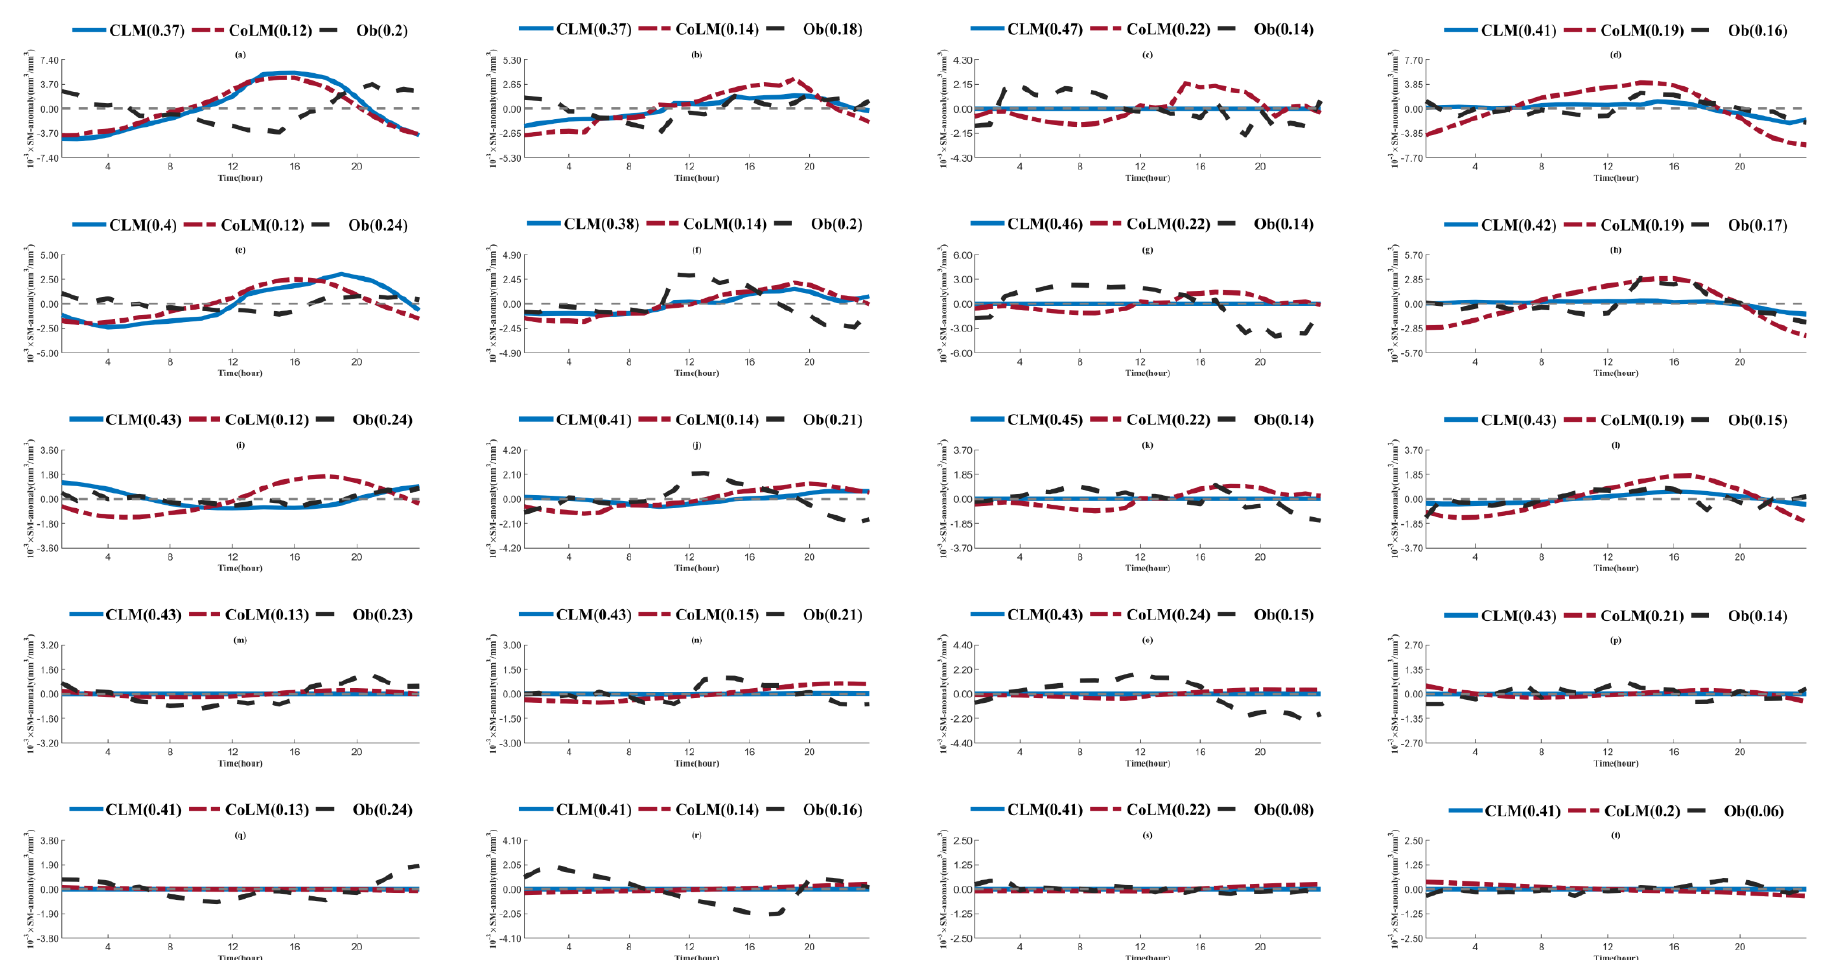
Figure 11. Diurnal variations in soil moisture anomalies for the four seasons at Powder Mill, with CLM5 in blue, CoLM2014 in red, and observations in black. The seasonal mean values of soil moisture are in brackets. ( a , e , i , m , q ) Soil moisture anomalies in winter in layers 1 to 5, respectively. ( b , f , j , n , r ) Soil moisture anomalies in spring in layers 1 to 5, respectively. ( c , g , k , o , s ) Soil moisture anomalies in summer in layers 1 to 5, respectively. ( d , h , l , p , t ) Soil moisture anomalies in autumn in layers 1 to 5, respectively.